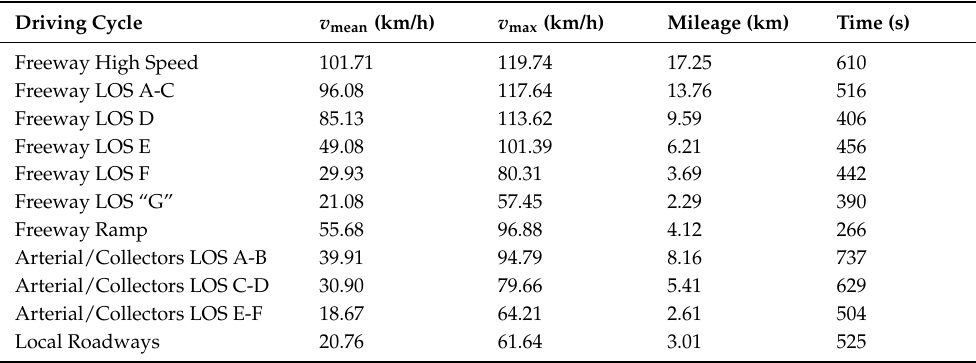
Table 3. Statistics of the 11 Facility-Specific Driving